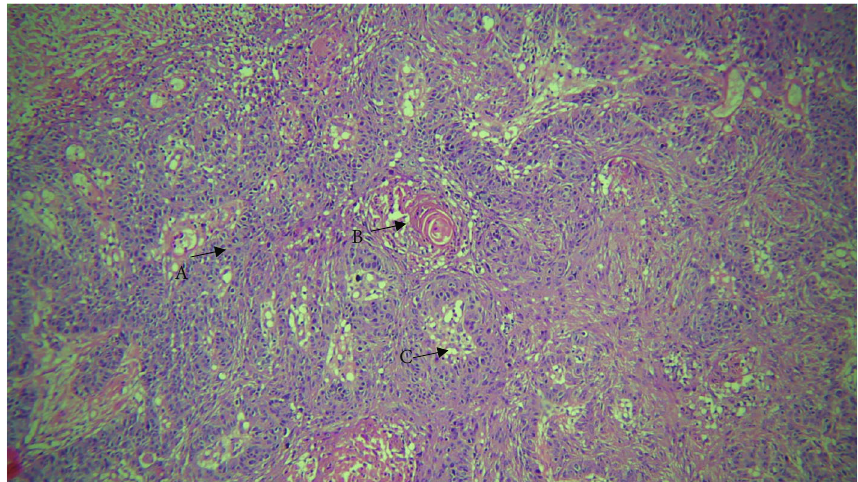
Figure 5: 4 × view. A: basaloid cells; B: keratin pearl; and C: comedo necrosis.